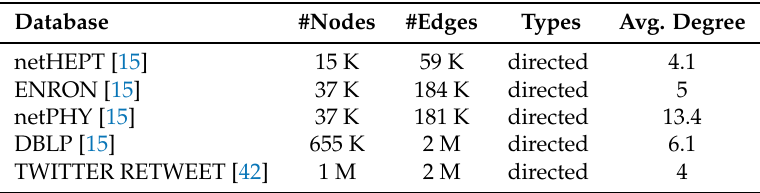
Table 1. Dataset’s